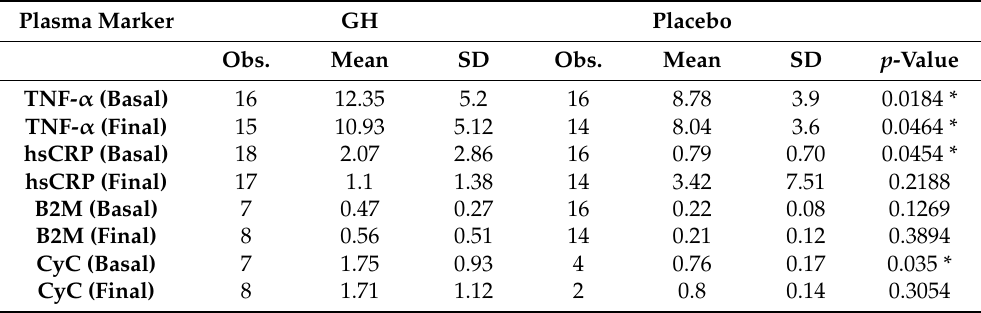
Table 3. Biomarker distribution in the GHAS study . Basal: Baseline or pretreatment values; Final : Final values after 2 months of treatment. Statistical significance is highlighted in colors. GH: Growth hormone; Obs: Observed; SD: Standard deviation; TNF- α : Tumor necrosis factor; hsCRP: C-reactive protein of high sensitivity; B2M: Beta-2 microglobulin; and CyC: Cystatin C. * p < 0.05.